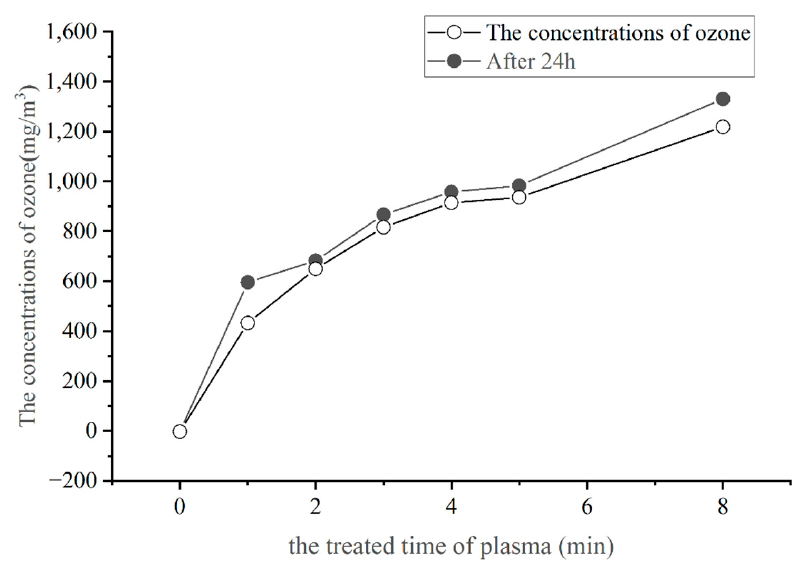
Figure 1. The quality of ozone produced by the plasma.